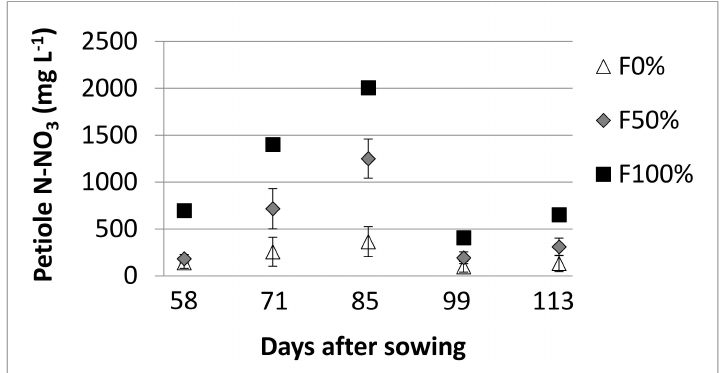
Figure 6. N-NO 3 in petioles during the growing